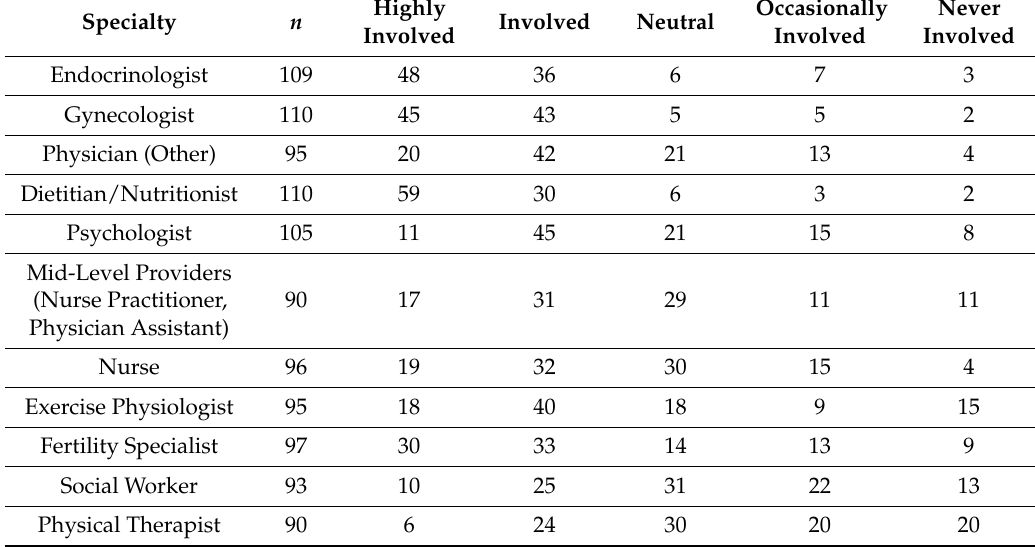
Table 5. Ideal involvement of specialties in future multidisciplinary PCOS clinics ( n = 113) as perceived by health care providers.